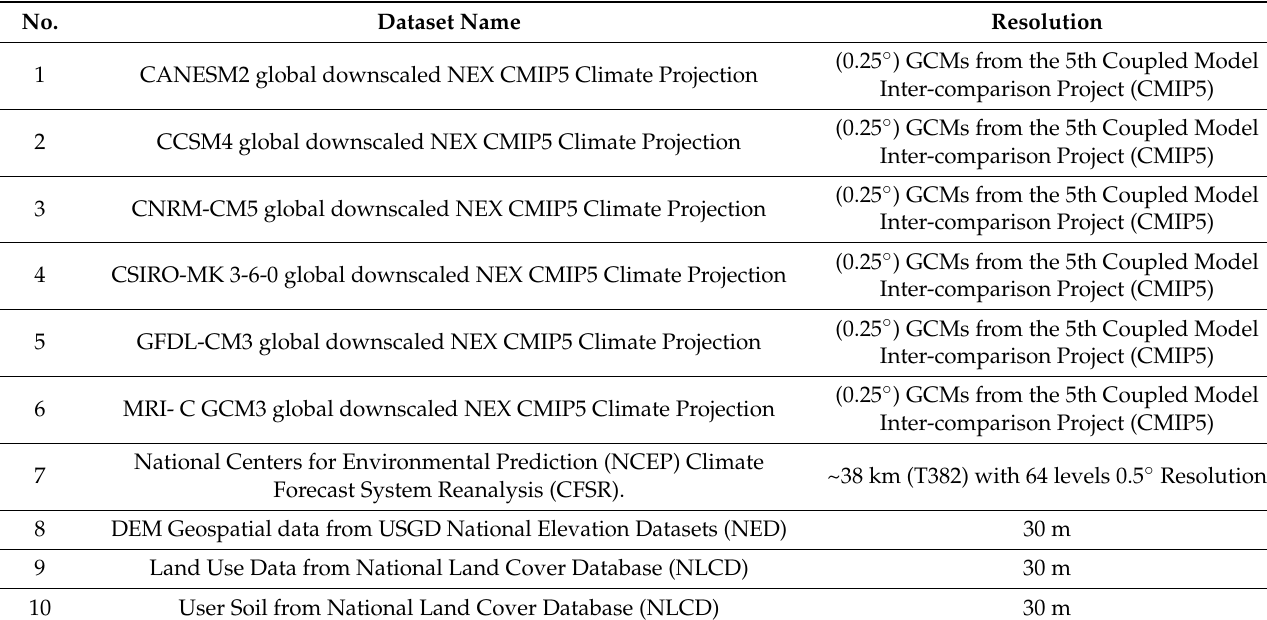
Table 3. Datasets and their resolution employed in the